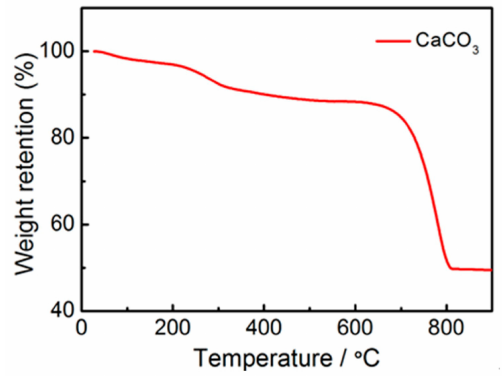
Figure 1. TG curve of CaCO 3